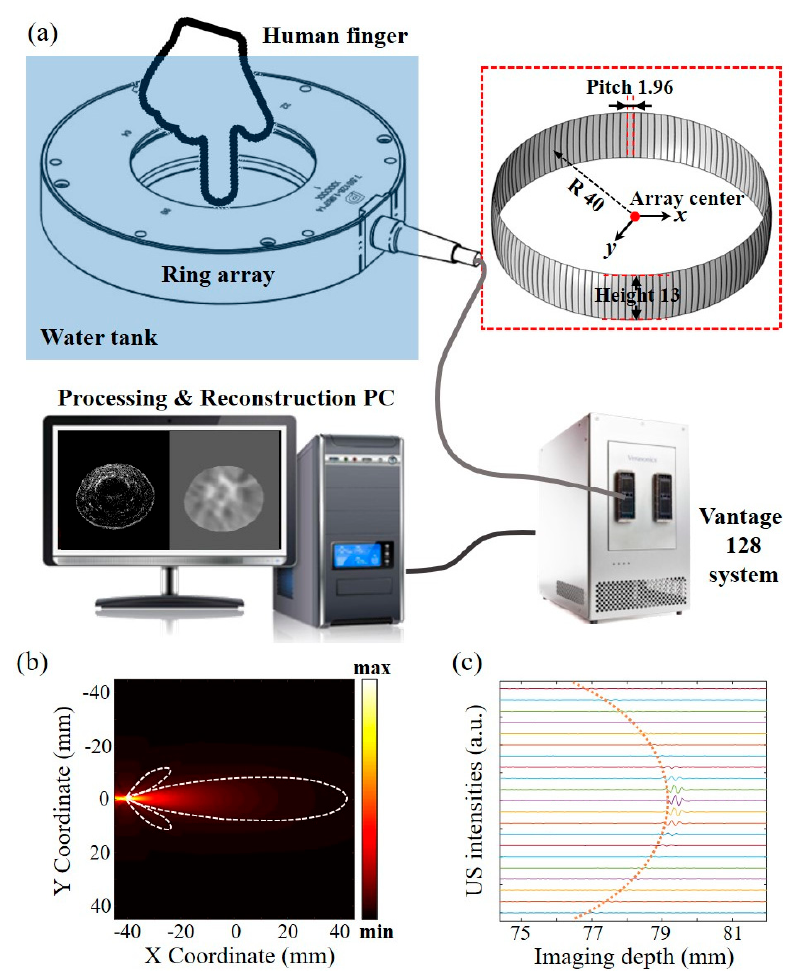
Figure 4. Schematic of the experimental setup and system calibration. ( a ) Experimental setup. ( b ) Acoustic field simulation of the first transmit. ( c ) US intensities versus the imaging depth.